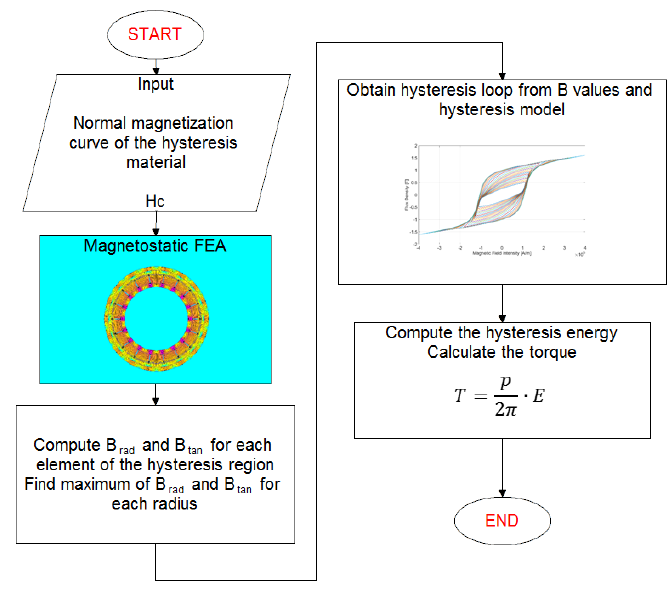
Figure 6. Flowchart of the proposed method.